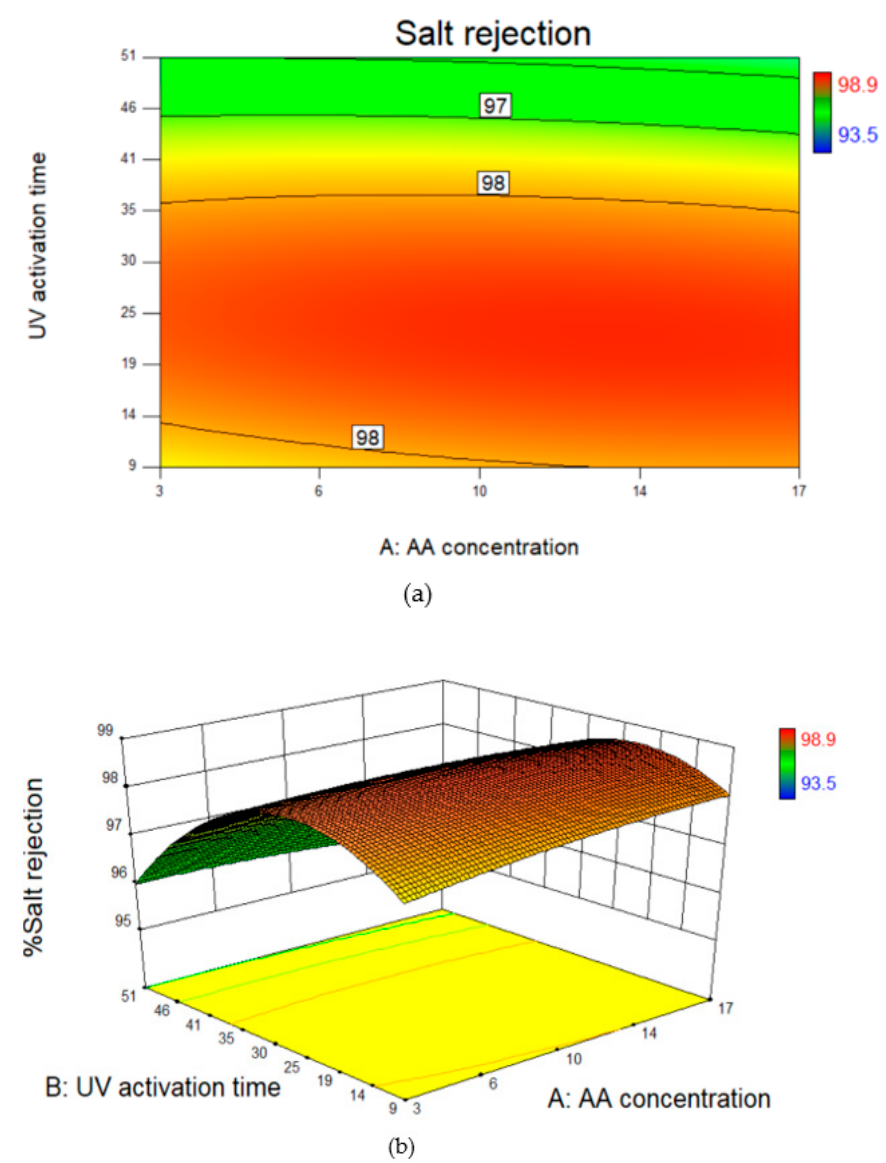
Figure 5. ( a ) Contour line map and ( b ) 3D surface plot for salt rejection as a function of acrylic acid concentration and UV activation time.